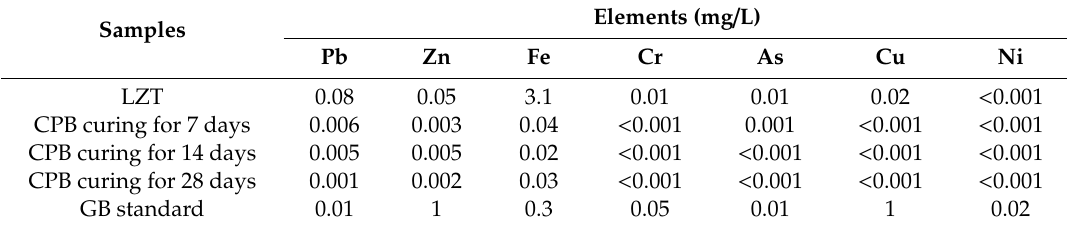
Table 7. Element concentration in toxicity characteristic leaching procedure